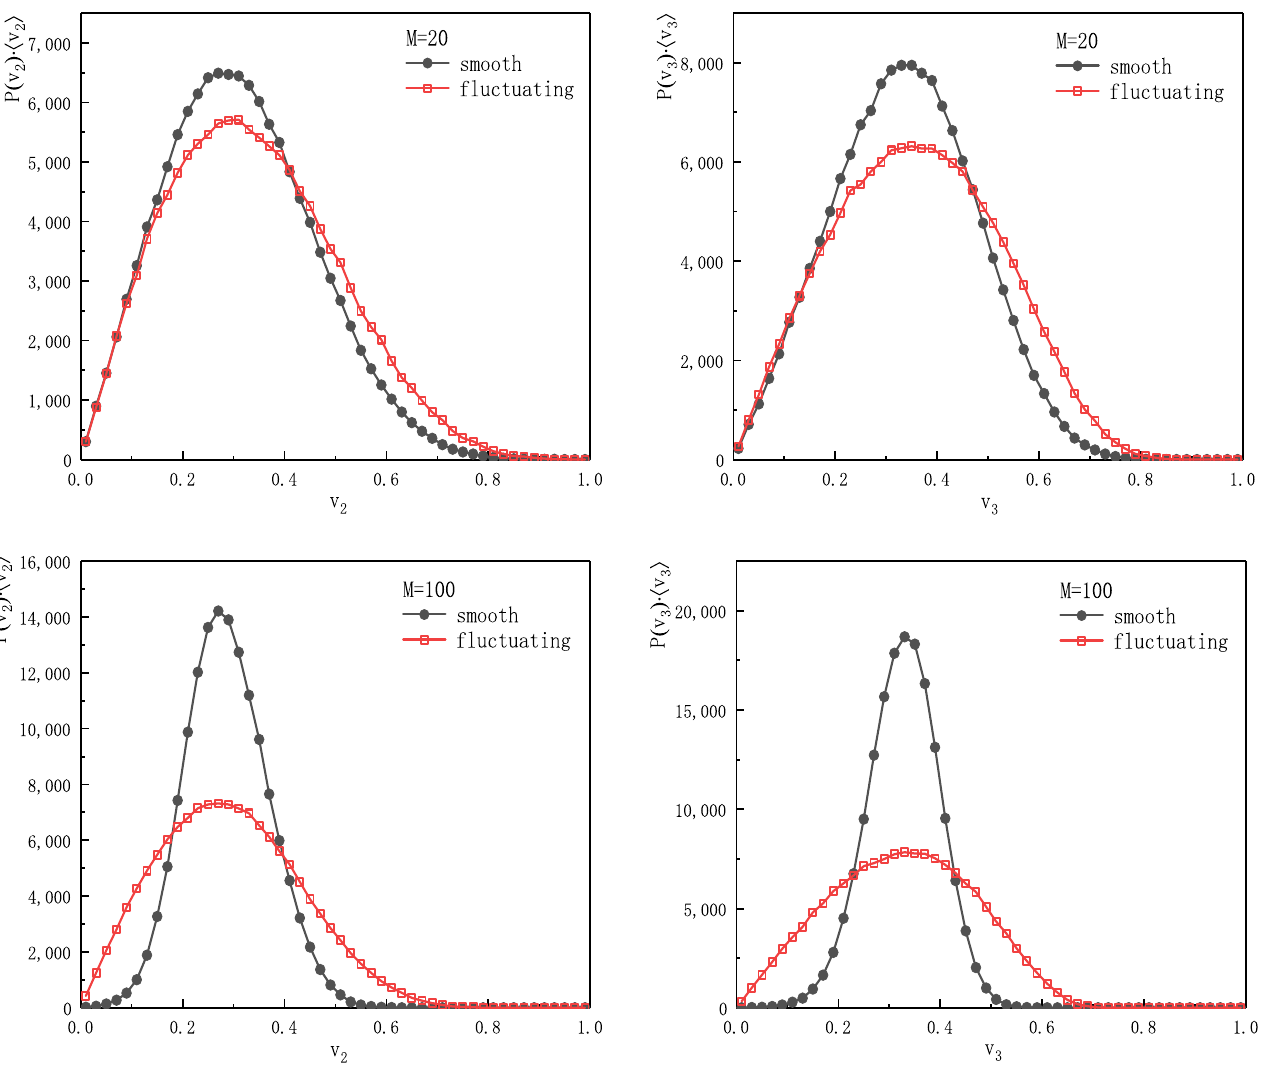
Figure 2. The probability distributions of triangular flow extracted for events of smoothed (black filled dotted) and event-by-event fluctuating (red empty squares) initial conditions generated with N = 10. The calculations are carried out by considering different event multiplicities M = 20 ( top row ) and M = 100 ( bottom row